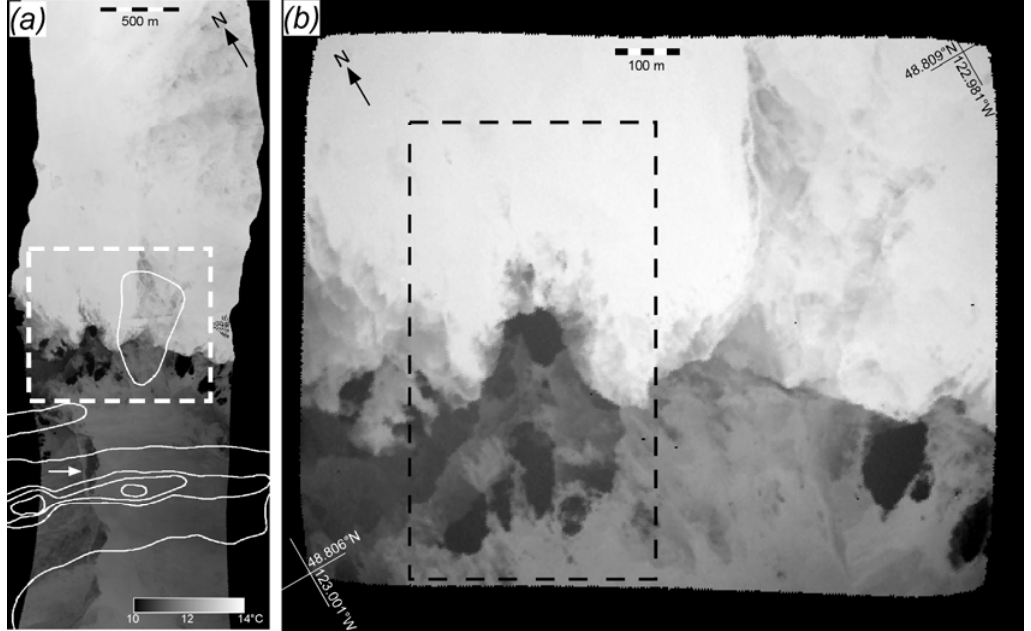
Figure 9. ( a ) IR geo-strip from 18 May 2009, 0335 UTC. Rectangle (white dashes) shows the fixed area imaged during data collection in staring mode; ( b ) A sample frame from the stare imagery, showing a near-nadir view of the sea surface. Area in rectangle (black dashes) is examined in the next